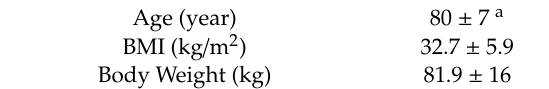
Table 1. Baseline characteristics of all eight elderly women included in this cross-over